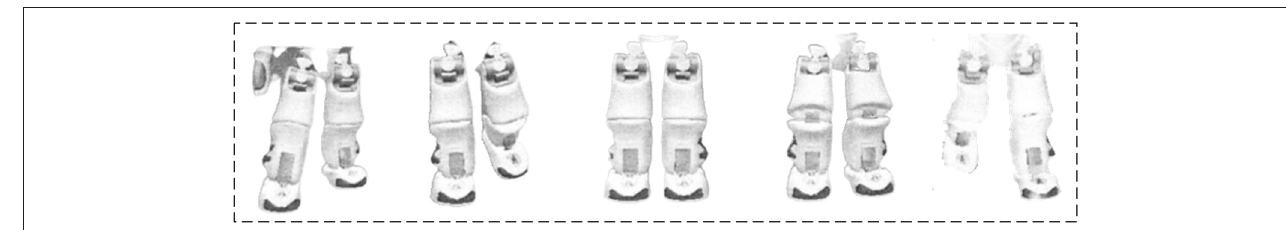
FIGURE 10 | Basic dance elements imitated on lower body L 3 (lower body).